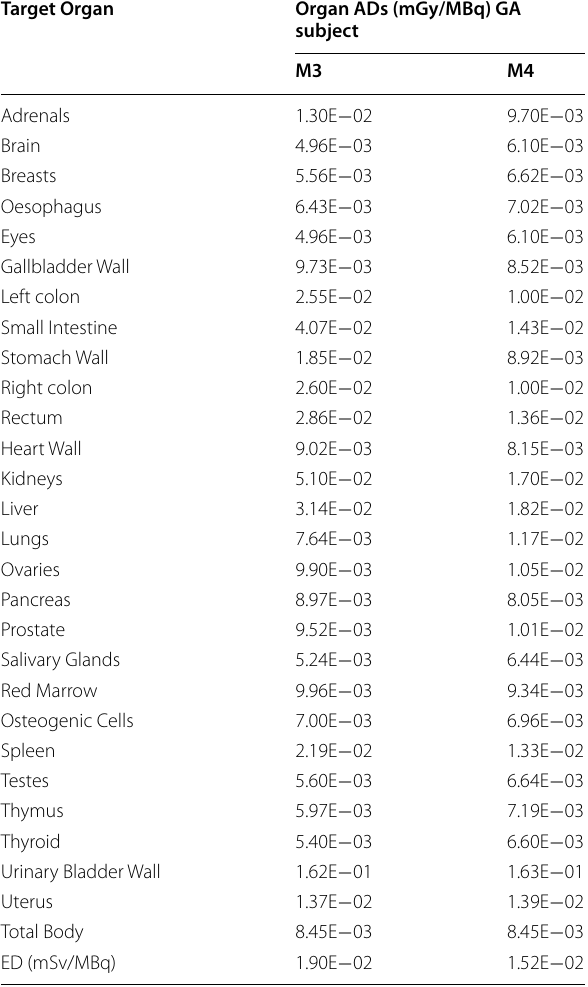
Table 5 [ 68 Ga]NODAGA-RGDyK: M3 and M4 reassessed using α new =